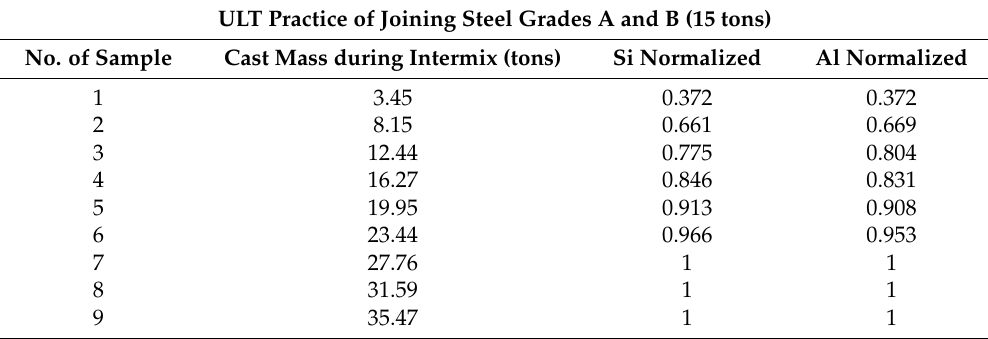
Table 4. Detailed course of the change in normalized composition for steel grades A and B (15